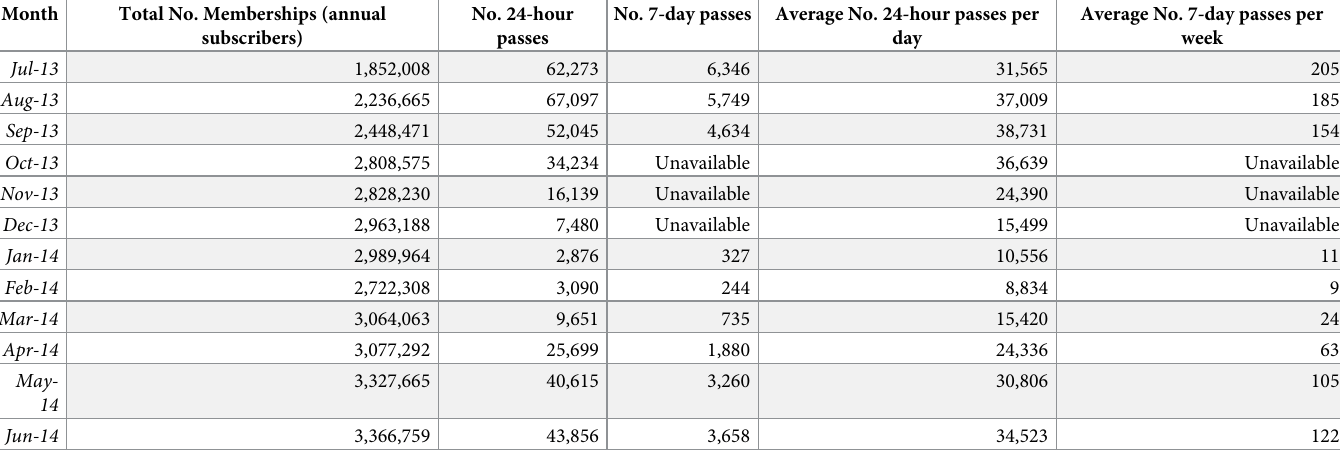
Table 1. Total number of memberships, 24-hour and 7-day passes purchased between July 2013 and August 2014. Month Total No. Memberships (annual subscribers)